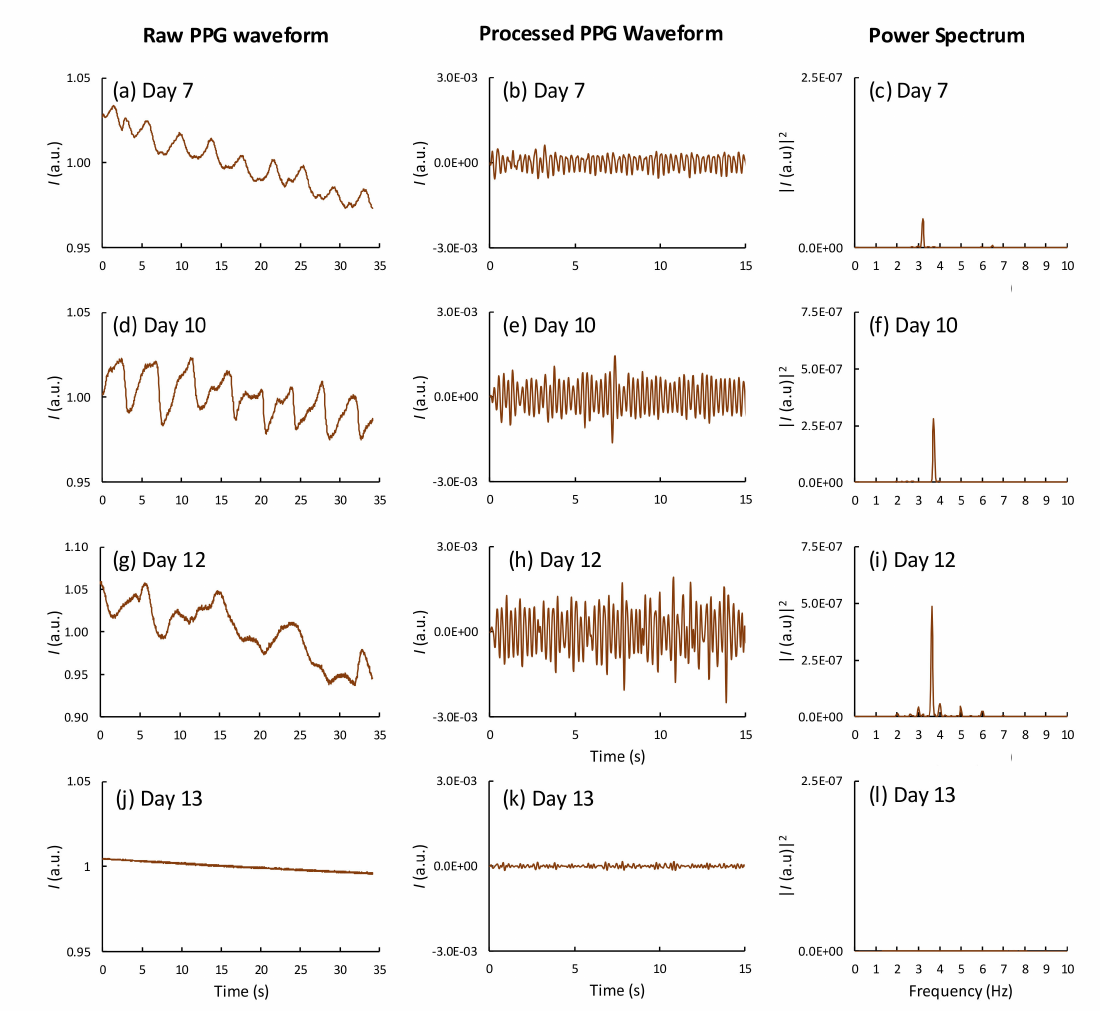
Figure 4. PPG waveforms and the corresponding power spectra obtained from an egg whose embryo